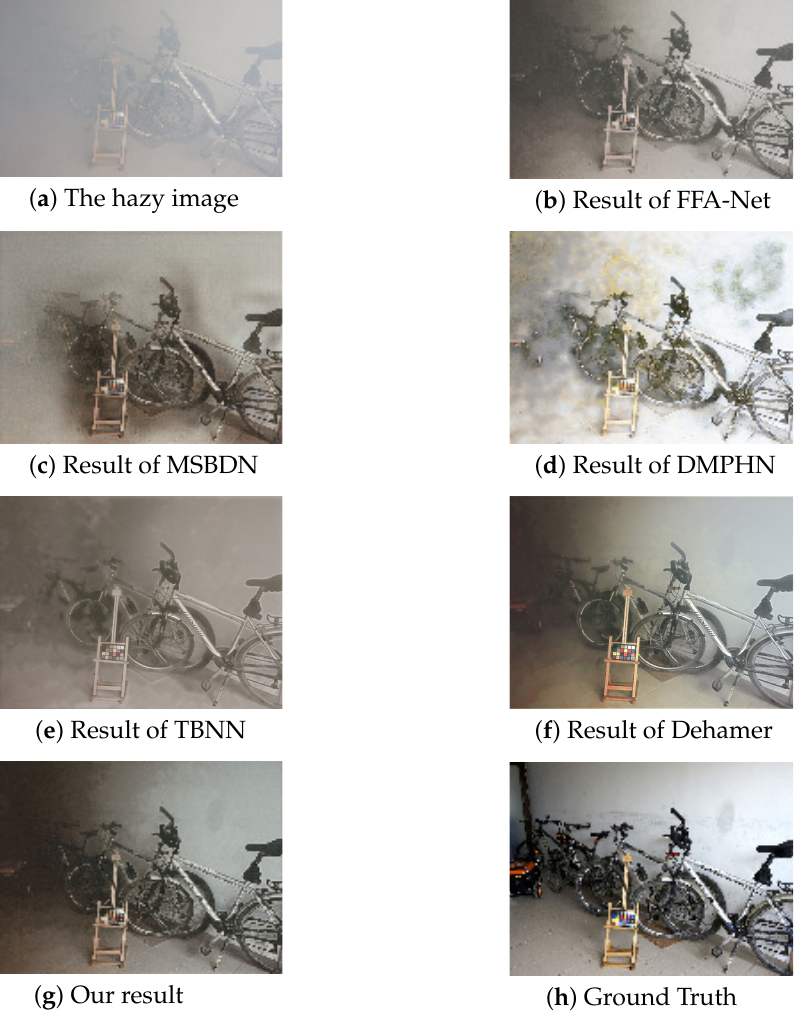
Figure 6. Qualitative comparison of dehazing results on an image with dense haze from the Dense- Haze